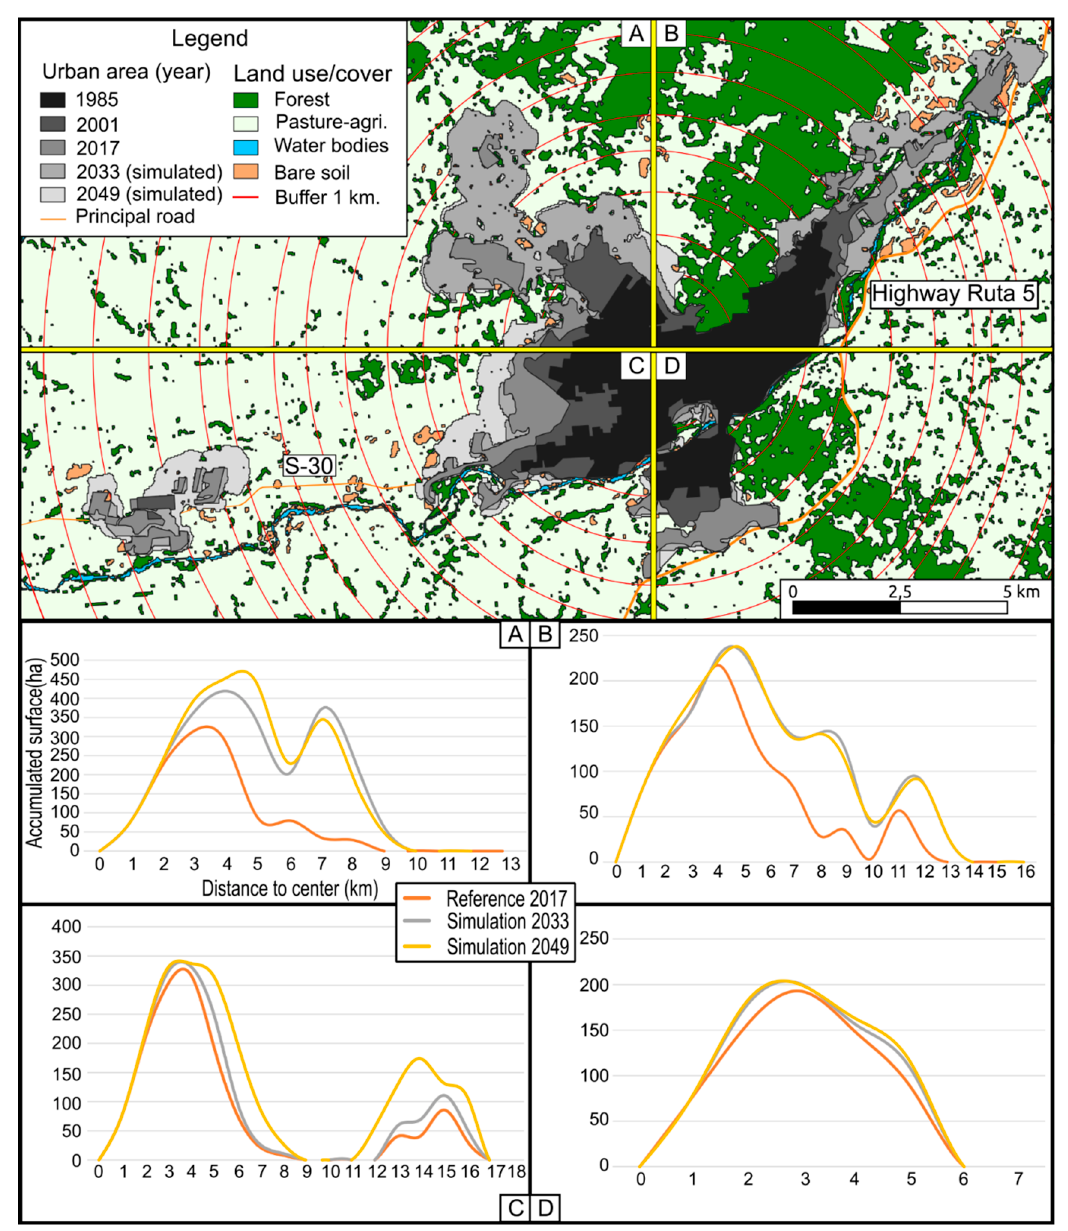
Figure 6. Simulation of urban growth of the city of Temuco as a function of distance. Source: Authors’ compilation.